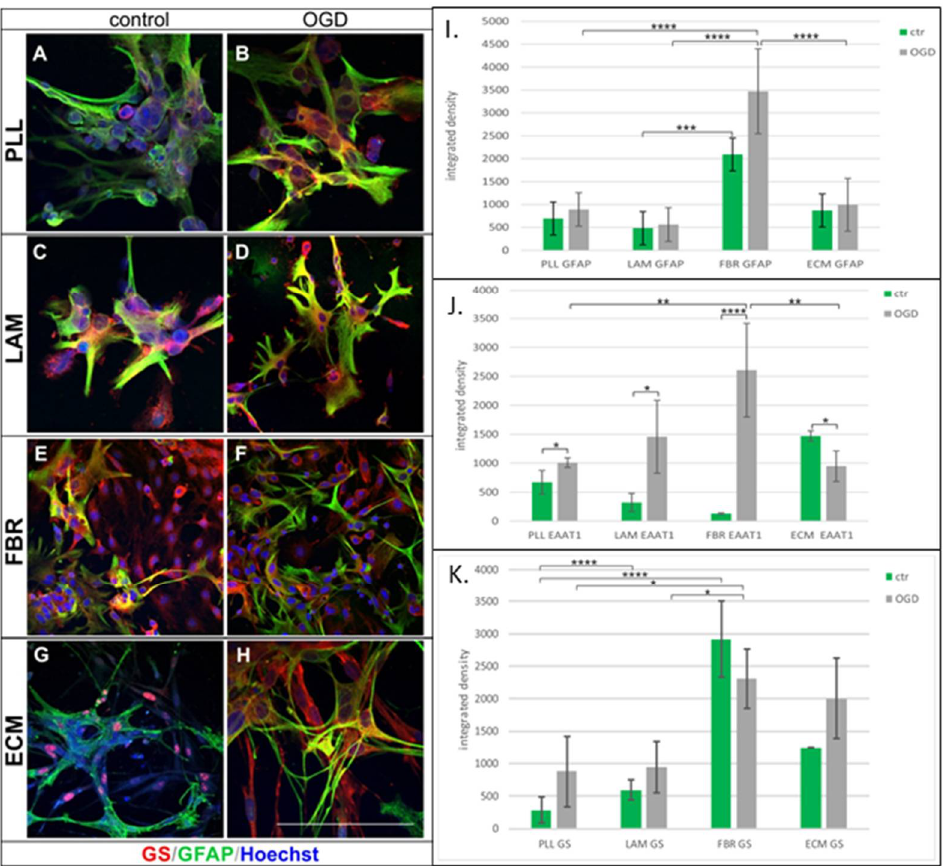
Figure 7. Influence of biomolecules used for astrocyte attachment on the expression of classical astrocyte markers: GS, GFAP, and EAAT1. Double immunocytochemical labelling of astrocytes (GS + /GFAP + ) cultured on surfaces coated either with PLL ( A , B ), Laminin ( C , D ), Fibronectin ( E , F ), or ECM gel ( G , H ). Cell nuclei are stained with Hoechst dye (blue). Scale bar represents 50 μm. ( I ) Analysis of GFAP marker expression in regard to biomaterial used for cell culturing; ( J ) Measured EAAT1 expression by astrocytes attached to various biomolecules. ( K ) GS expression depends on the biomolecule used for coating the culture surface. * p < 0.05, ** p < 0.01; *** p < 0.001, **** p < 0.0001.